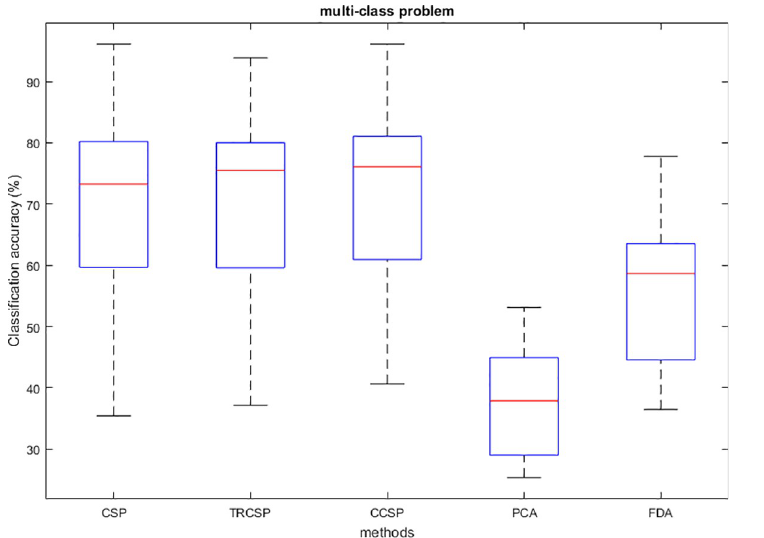
Fig 8. Boxplot of all subject for CSP, TRCSP and CCSP in multi-class problem.